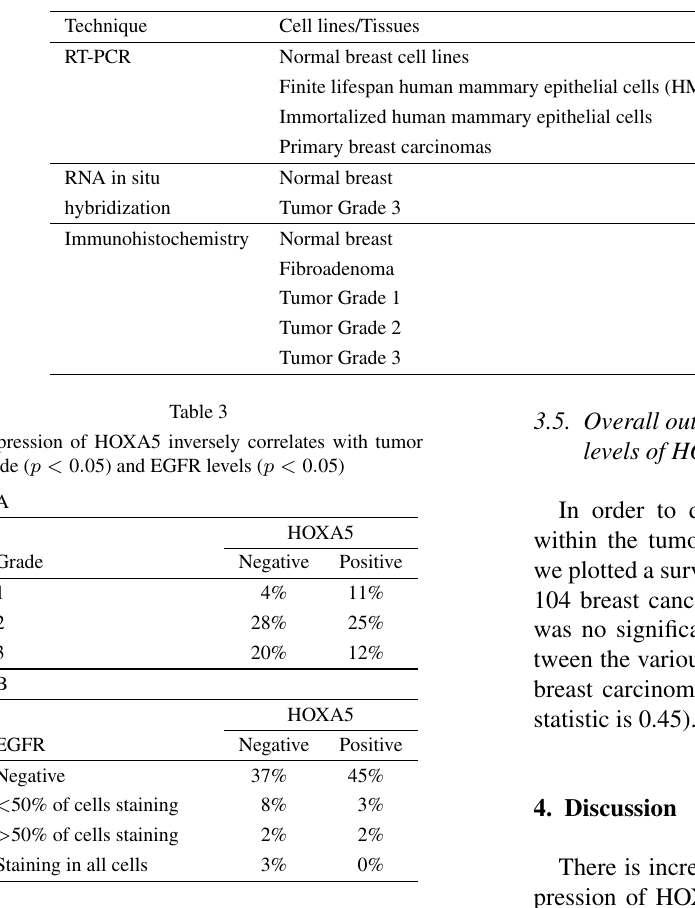
Techniques used to analyze HOXA5 expression